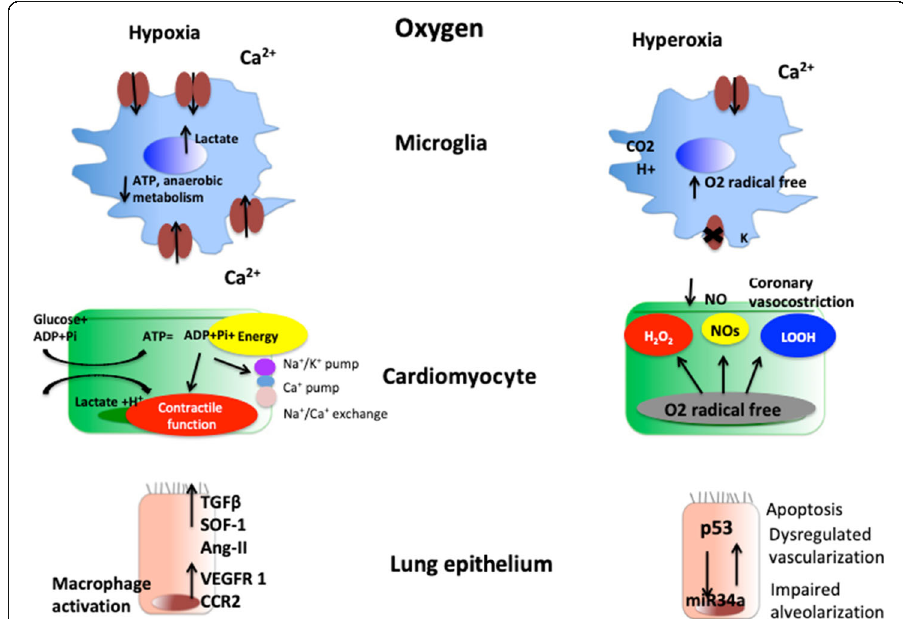
Fig. 2 Effect of oxygen on microglia, cardiomyocytes, and lung epithelial cells. Microglia: hypoxic neurons have an anaerobic metabolism with increased intracellular Ca 2+ intake; persistent hypoxia generates reduction of ATP and further energetic failure. Hyperoxia can disrupt microglia function by increasing free radicals. Hyperoxia increases input resistance to antioxidant and decrease membrane conductance (K+ channel) and stimulates firing of putative central CO 2 /H + chemoreceptors neurons. Cardiomyocytes: